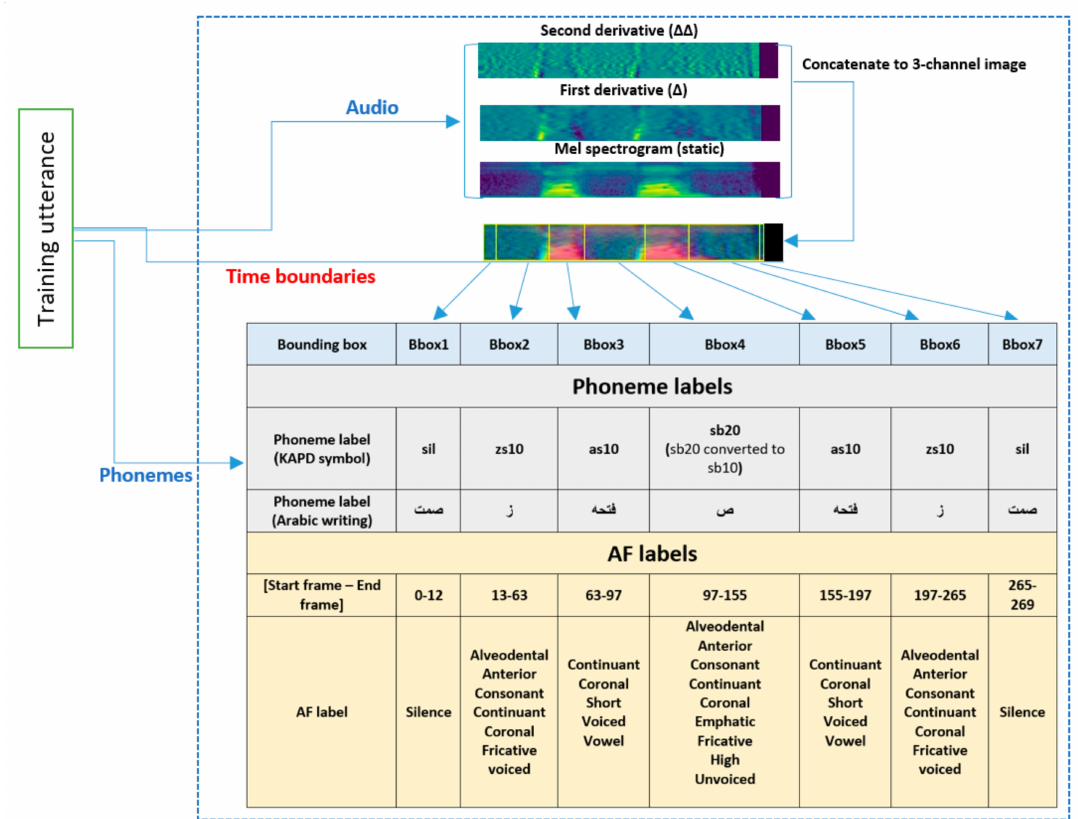
Figure 6. Example of creating a three-channel image and related bounding